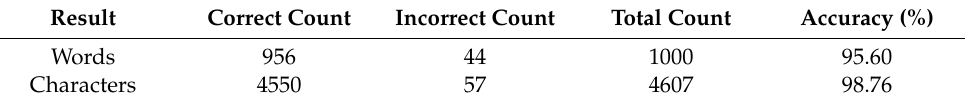
Table 7. Recognition results.